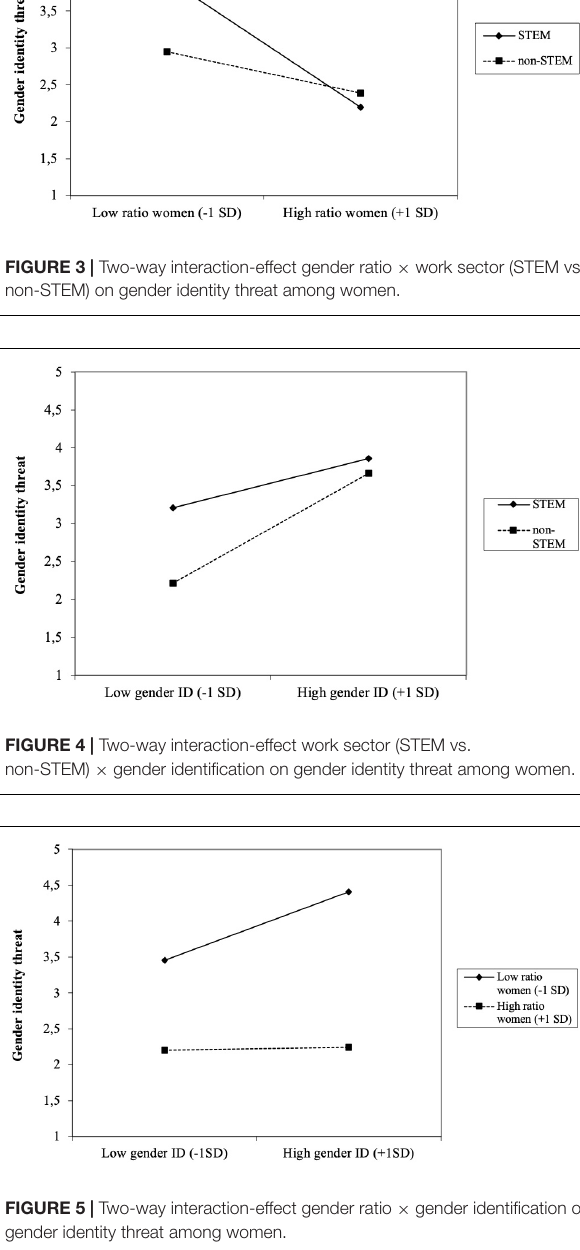
FIGURE 5 | Two-way interaction-effect gender ratio × gender identification on gender identity threat among